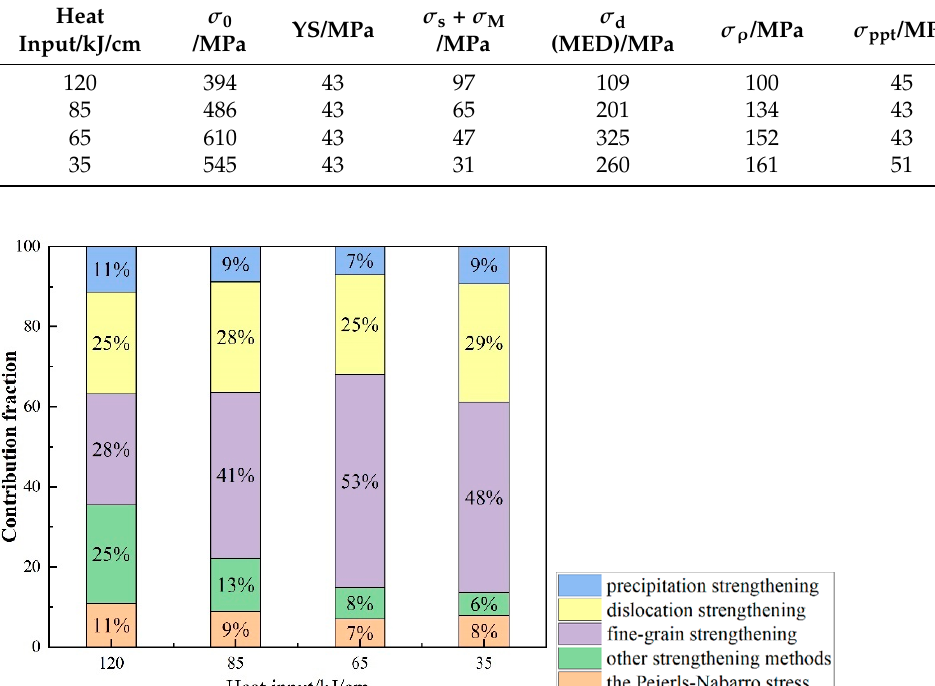
Table 3. Summary of individual strengthening contribution of various microstructural features of all the samples. Heat Input/kJ/cm